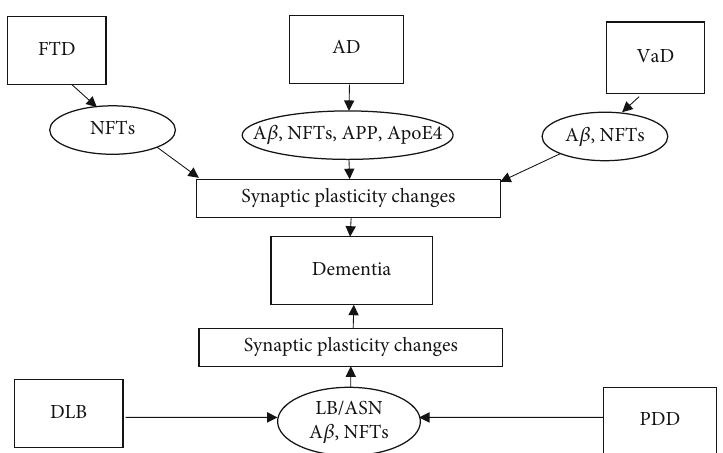
Figure 3: Changes in synaptic plasticity and the development of dementia in common dementia diseases. AD: Alzheimer ’ s disease; FTD: frontotemporal dementia; VaD: vascular dementia; DLB: dementia with Lewy bodies; PDD: Parkinson ’ s disease (PD) dementia; A β : β - amyloid; NFTs: neuro fi brillary tangles; APP: amyloid precursor protein; LB: Lewy bodies; ASN: alpha-synuclein; ApoE4: apolipoprotein